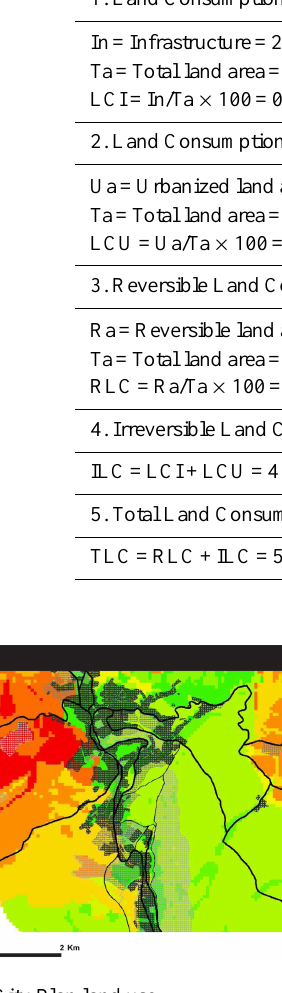
Fig. 8. Example of City Plan land use.